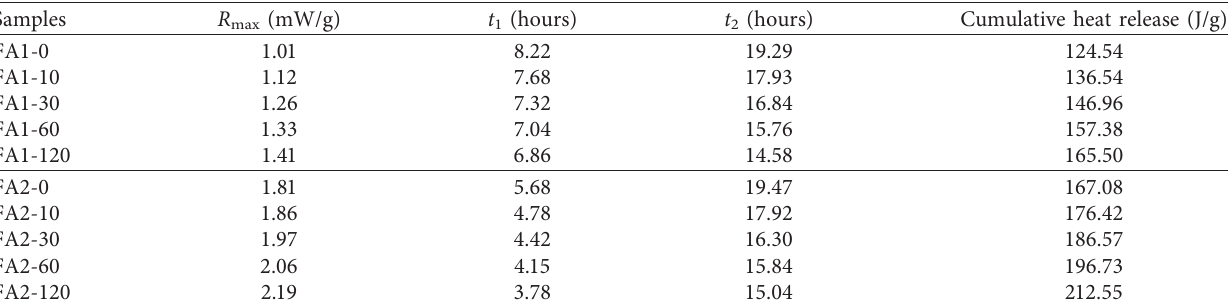
Figure 9: Calorimetry test results: (a, b) heat flow rate and (c, d) cumulative heat release. Table 4: Kinetic data for the all the